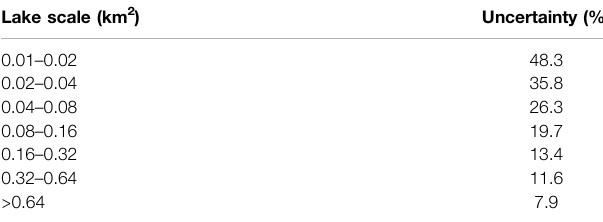
TABLE 1 | Uncertainty of different area